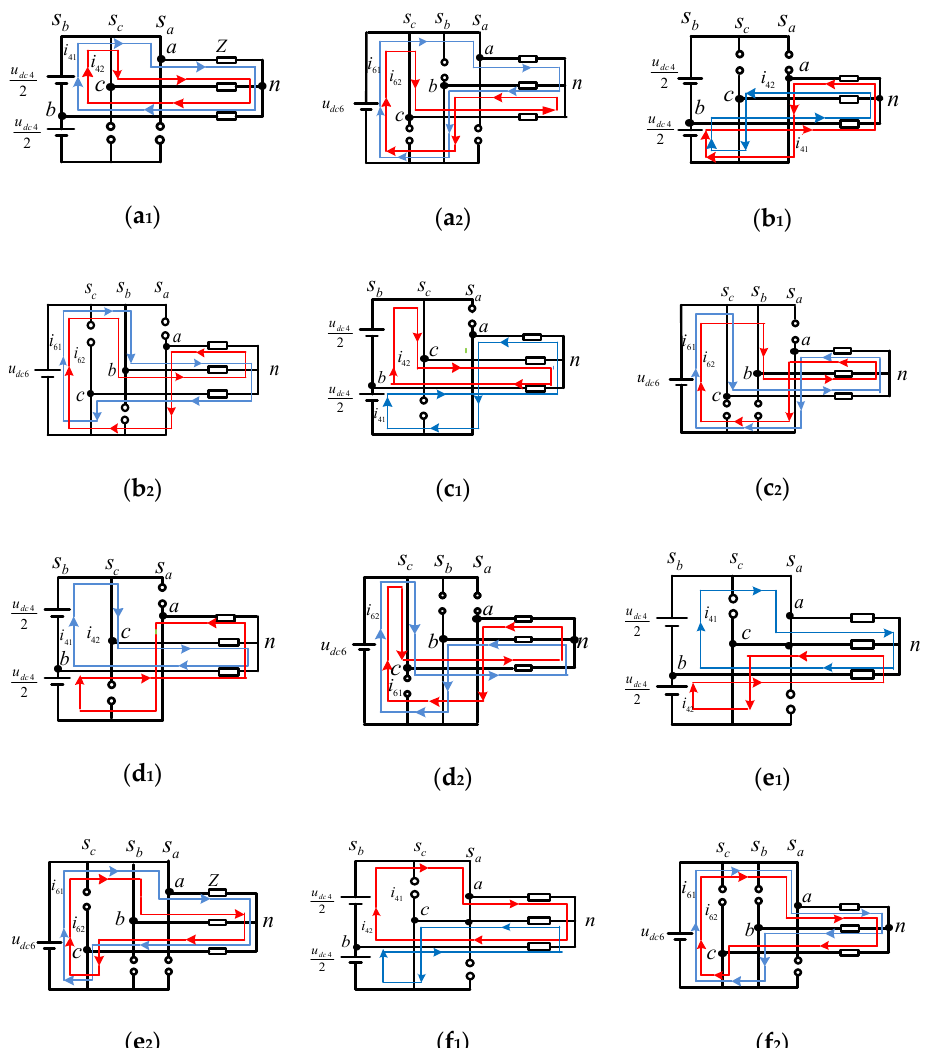
Figure 4. Switching modes and current paths (S a , S c ) for the faulty state and (S a , S b , S c ) for the normal state: ( a 1 ) (1,1); ( a 2 ) (1, 0, 1); ( b 1 ) (0,0); ( b 2 ) (0,1, 0); ( c 1 ) (0,1); ( c 2 ) (0,1, 1); ( d 1 ) (0,1); ( d 2 ) (0,0, 1); ( e 1 ) (1,0); ( e 2 ) (1,1, 0); ( f 1 ) (1,0); ( f 2 ) (1,0, 0) .